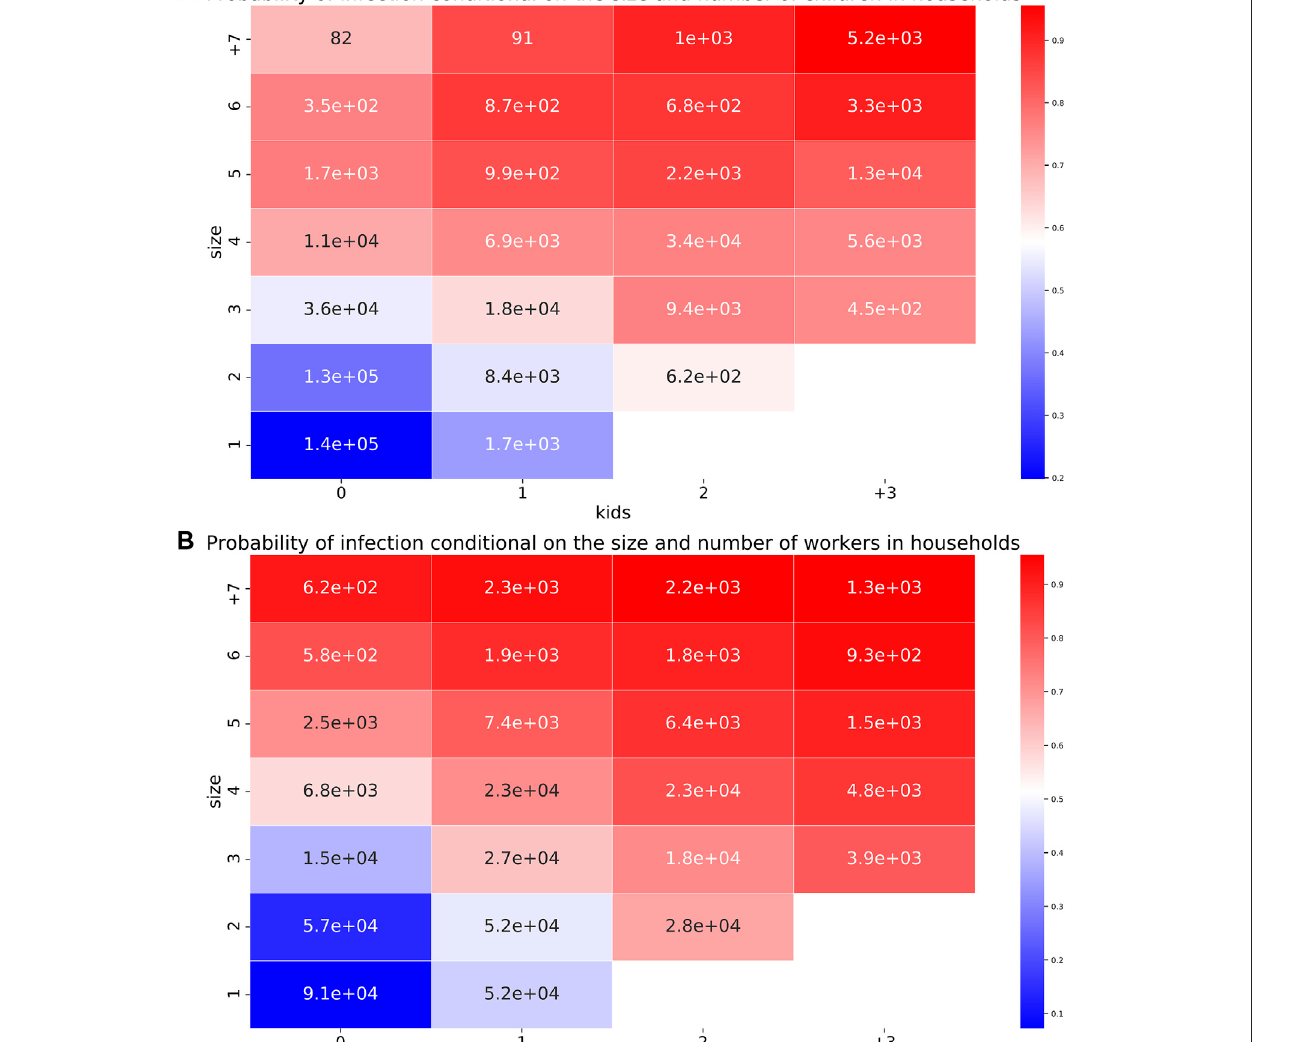
Frontiers in Built Environment |